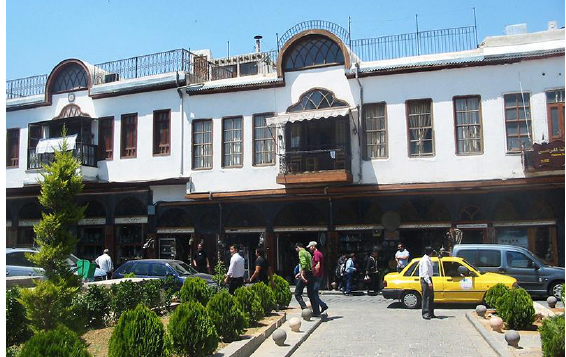
Figure 2. Shops on Medhat Pacha Street, R.Aboukhater, April 2010.